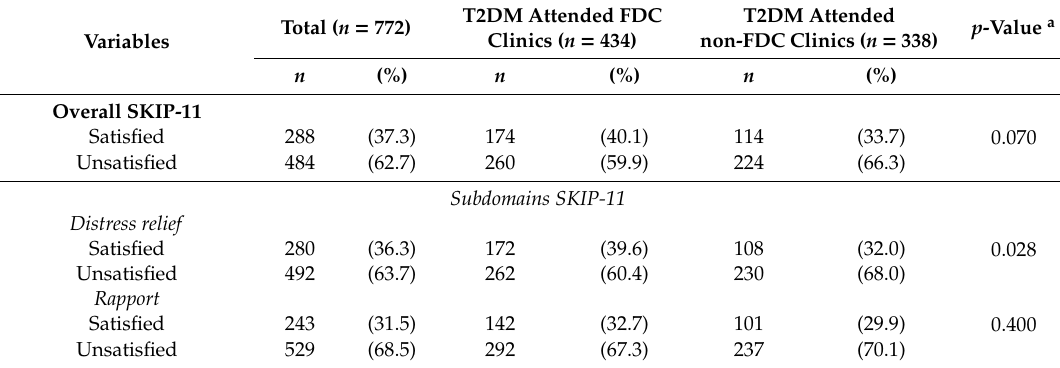
Table 3. Comparison of doctor-patient interaction satisfaction and glycaemic control among T2DM attended primary health clinics in Kelantan ( n =